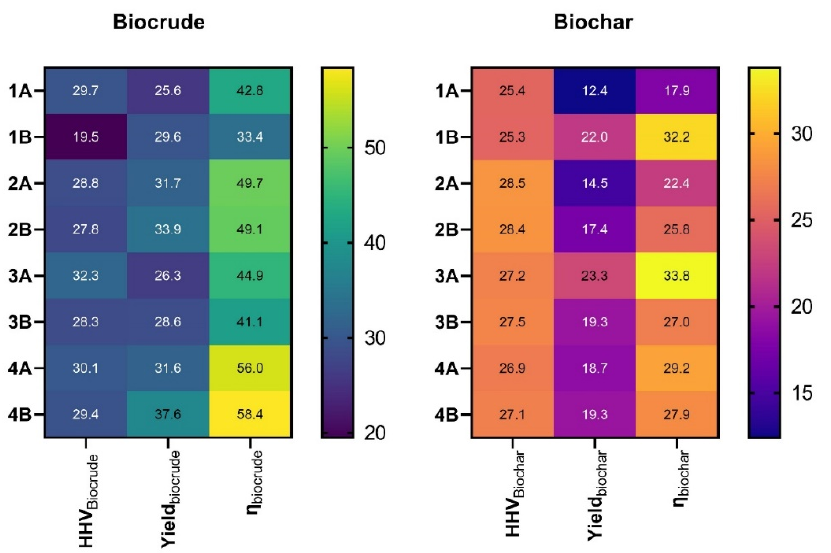
Figure 3. Heat map comparing the energy yields of the obtained biocrude and biochar. The HHV is reported in MJ/kg and the yields in %. In the rows, the numbers refer to each plant species: 1, Iris pseudacorus ; 2, Juncus effusus ; 3, Phragmites australis ; and 4, Typha latifolia . The letters A and B refer to the growing environments: A = TW, and B = NC environment.